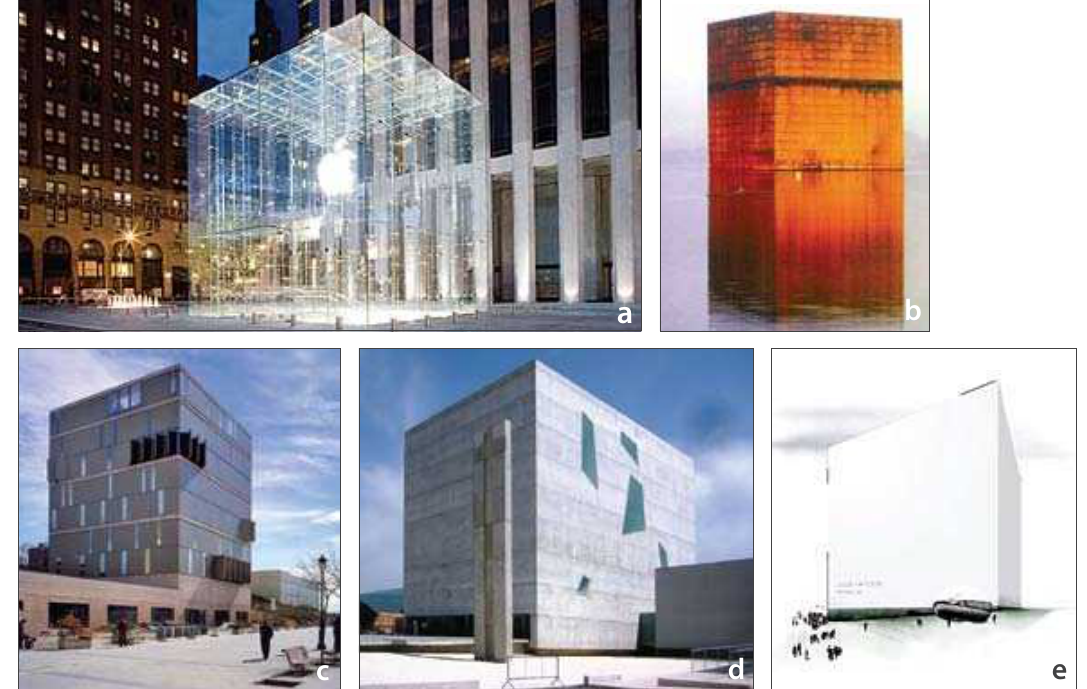
Fig. 2. apple Store; New York; arch. bohlin cywinski Jackson, 2007 (a); expo 2002; Murten-Morat, Switzerland. atelier Jean Nouvel, 2002 (b); Usera Public Library; Madrid, Spain; arch. abalos & herreros, 2005 (c); church; Folinjo, Italy. arch. M. Fuksas, 2009 (d); National Museum (I stage competition work); Oslo, Norway. arch. Urban canvas, 2009